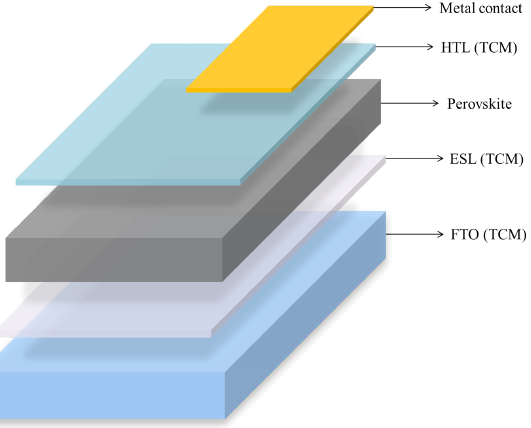
Figure 3. A typical schematic of a solar cell using both n- and p-type TCMs. The cells consist of metal contacts, a hole transport layer (HTL), an absorber layer, and an electron transport layer